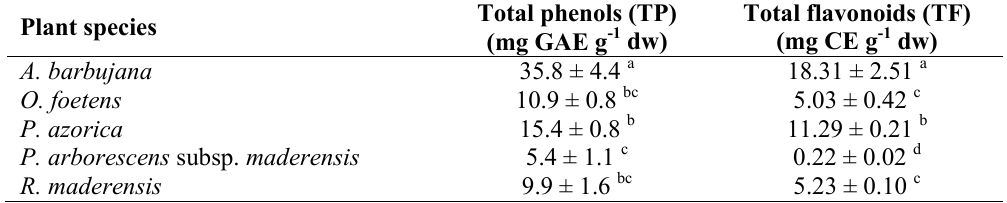
Table 2. Total phenols (TP) content and total flavonoids (TF) content for the water:ethanol extracts of the five Macaronesia plants under study. Values are the mean of three independent replicates ± SD. Superscript letters are the significance levels at p < 0.05.